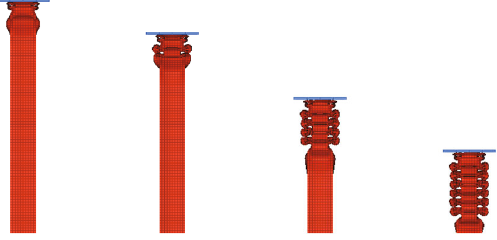
Figure 18: The deformation history of uniform thickness tube.